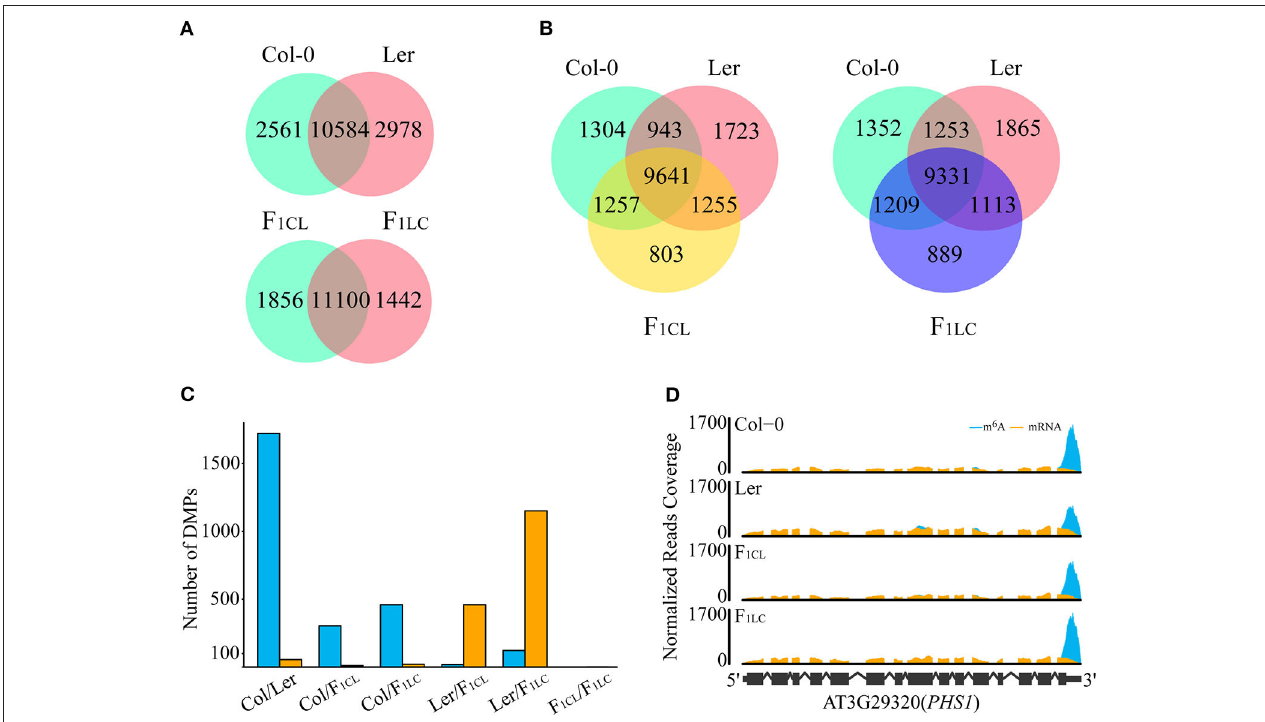
FIGURE 2 | Differences in m 6 A modifications among Col-0, Ler, and their F 1 reciprocal hybrids. (A,B) Number of shared m 6 A peaks between accessions. (C) Number of DMPs in each comparison. Blue bars, DMPs showing upregulated m 6 A intensity in the former comparison. Orange bars, DMPs showing upregulated m 6 A intensity in the latter. (D) Diagram for differentially methylated peaks. m 6 A, normalized IP reads; mRNA, normalized input